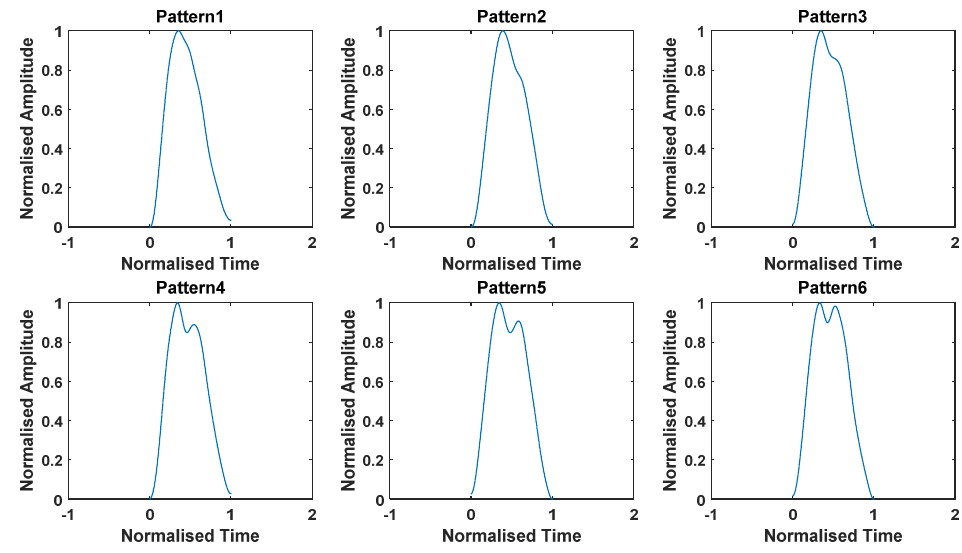
Figure 4. Six common thigh angle patterns observed in all trials.